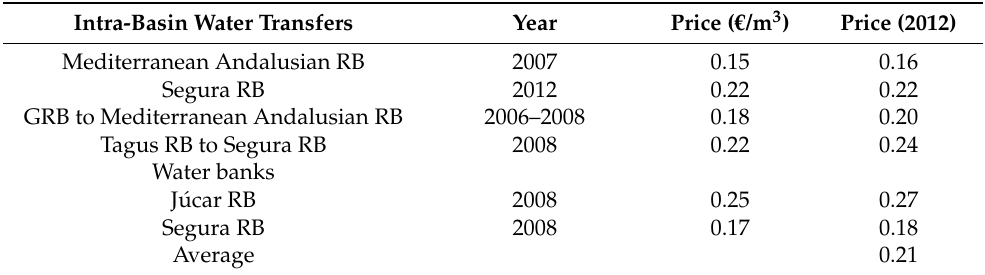
Table 6. Evidence on prices of water sales and water banks in